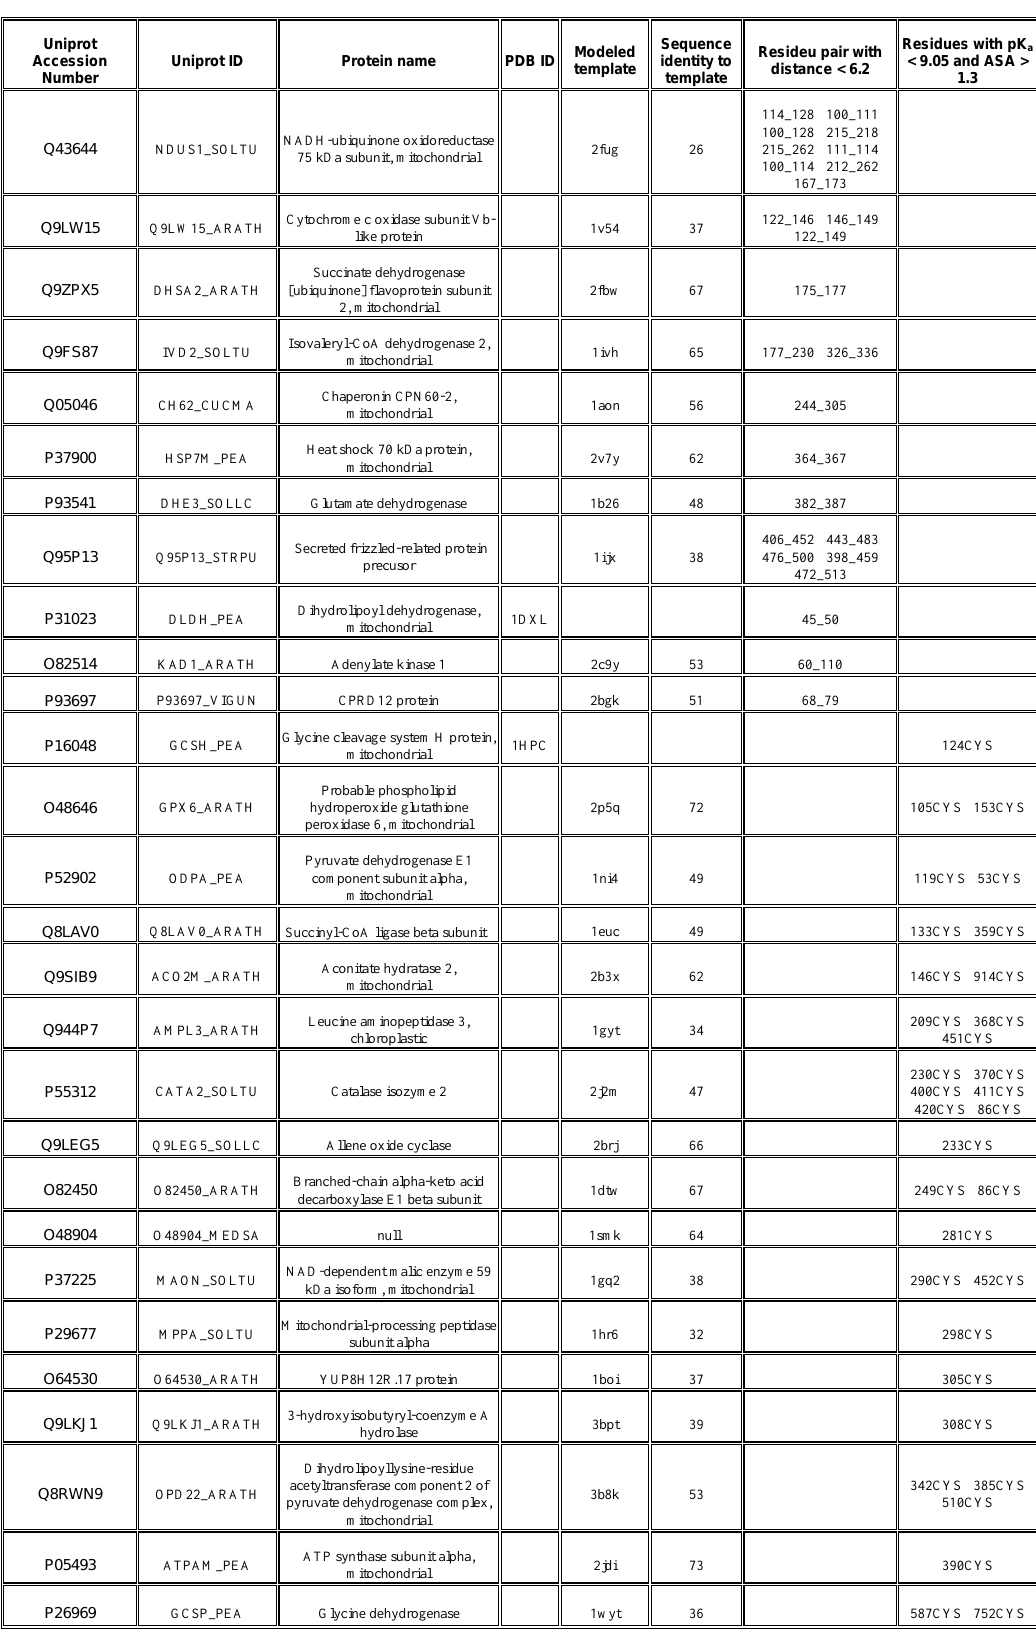
Tab. 2: Result from applying ROCD on 46 thioredoxin target proteins in plants. The PDB ID in upper case letters are the exact structure entry for the protein, and the PDB ID in lower case is obtained by homology modeling. The two digits separated by underscore in Note1 column mean the cysteine residue pair, and Note2 column records the qualified residue number and residue